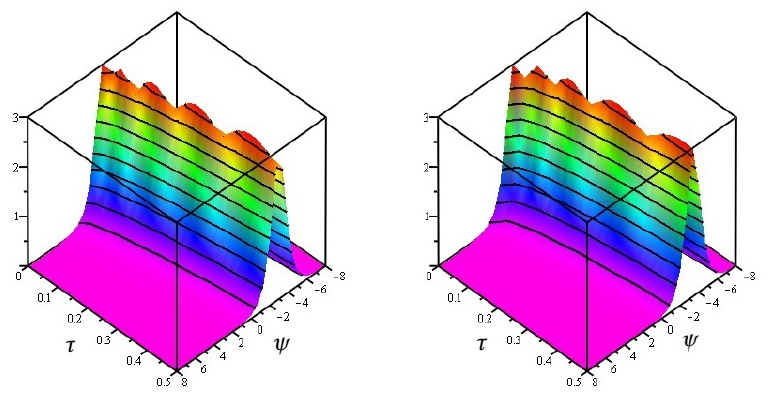
Figure 5. The analytical solutions of ϕ ( ψ , τ ) at (cid:118) = 0.6 and 0.4.